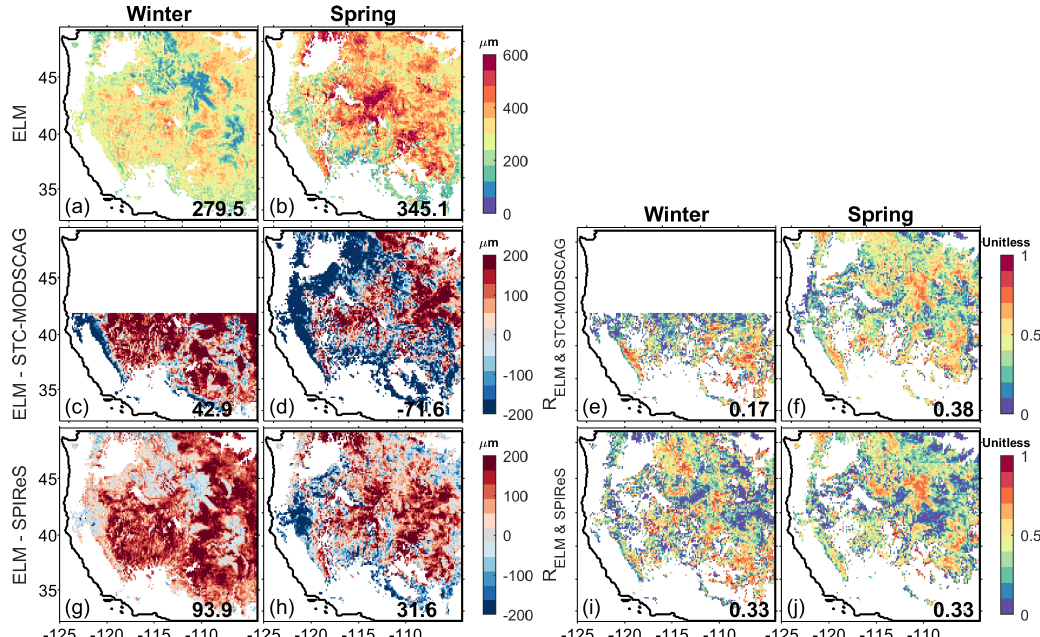
Figure 10. Spatial distributions of (a, b) snow grain size ( S sno ) in ELM, and (c, d, g, h) the S sno difference between ELM and two remote sensing products (i.e., STC-MODSCAG and SPIReS) and (e, f, i, j) their temporal correlations ( R s ) for different seasons: (a, c, e, g, i) winter and (b, d, f, h, j) spring. In all panels, regions with no snow cover are masked with white color. The area-weighted average values are labeled in each panel.